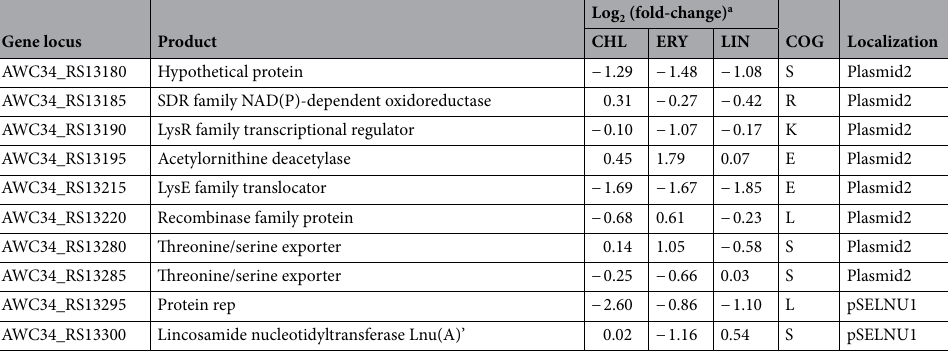
Table 1. Expression of S. equorum KM1031-specific genes (identified by comparative genomic analysis) following treatment with chloramphenicol, erythromycin or lincomycin. Control indicates strain KM1031 cultured without antibiotics. CHL chloramphenicol, ERY erythromycin, LIN lincomycin, COG clusters of orthologous groups. a [Fold-change] was defined as [TMM antibiotic /TMM control ]. Values are means from duplicate experiments.